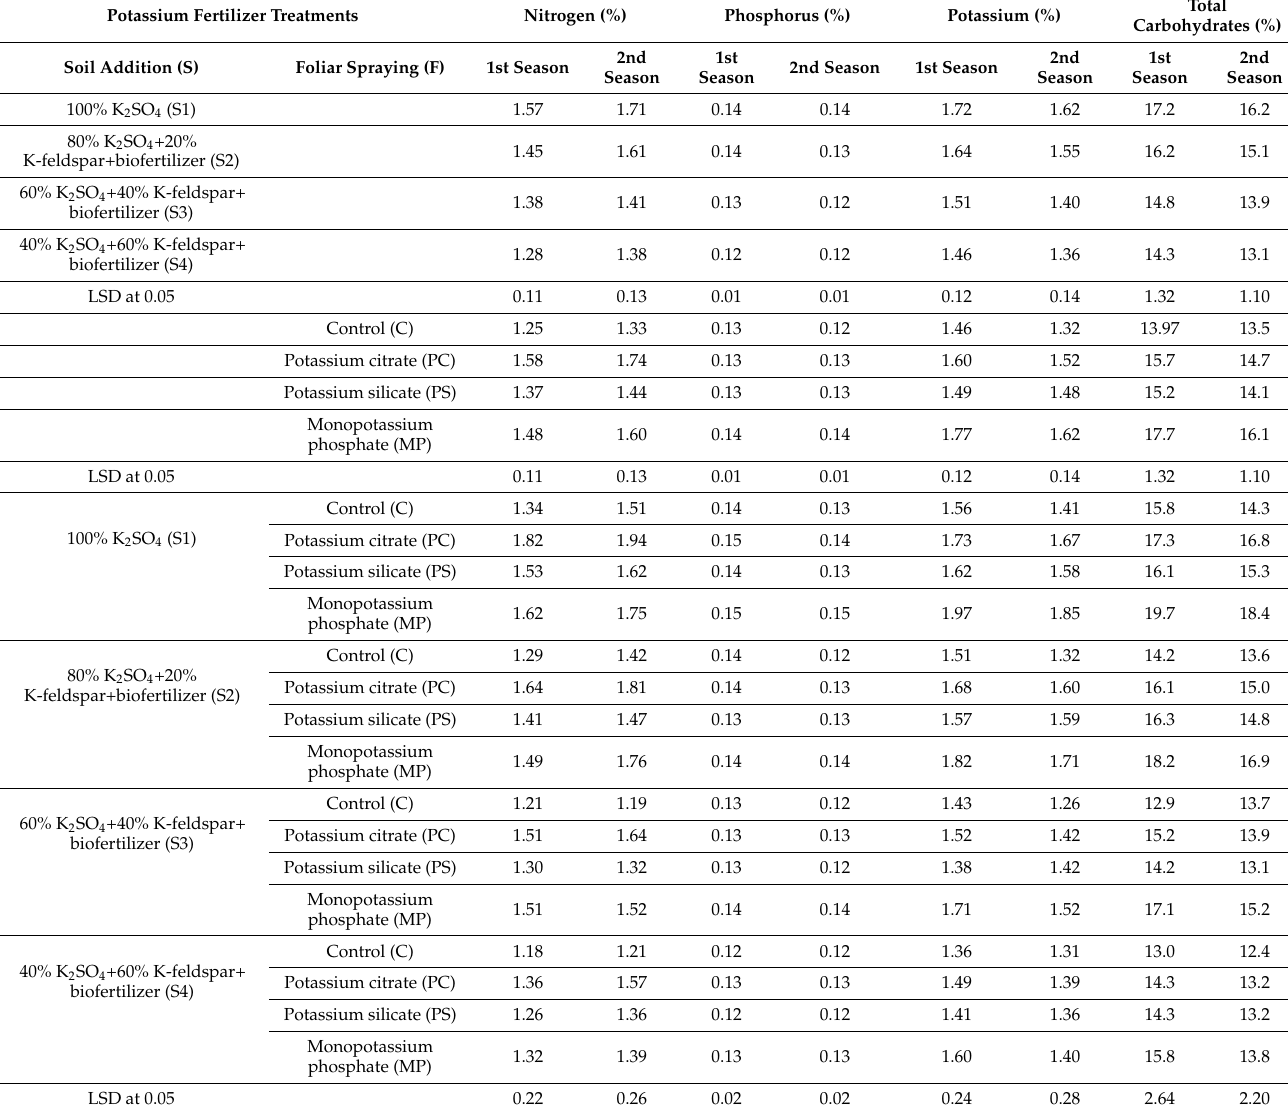
fertilizers with compost and biofertilizers may affect macronutrient content in potato leaves at 75 days after planting. The findings of our study indicate that covering most of the plant potassium requirements with inorganic mineral fertilizers (e.g., S1 and S2 treatments) as well as via the foliar spraying of monopotassium phosphate and potassium citrate may in- crease K uptake by plants due to better availability and consequently improve biosynthetic processes and carbohydrate assimilation. Table 4. The effect of potassium fertilization with soil addition (S) or foliar spraying (F) on the chemical composition of potato leaves during the 2018 and 2019 growing seasons (results are expressed on a dry weight basis). Potassium Fertilizer Treatments Nitrogen (%) Phosphorus (%) Potassium (%) Total Carbohydrates (%) Soil Addition (S) Foliar Spraying (F) 1st Season 2nd Season 100% K 2 SO 4 (S1)